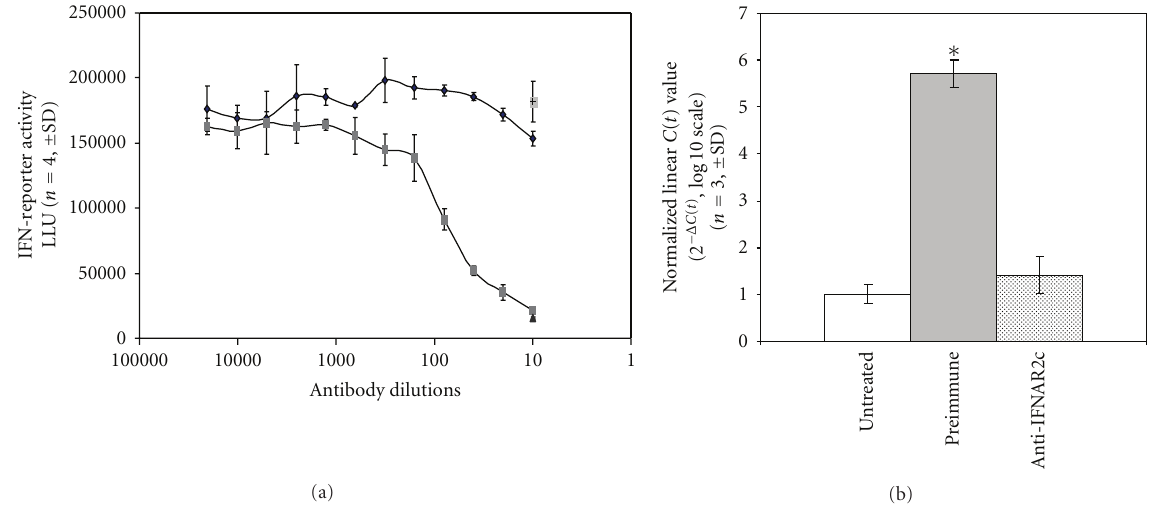
Figure 3: IFN- β induction of RGS1 is dependent on IFN-receptor activation . Neutralizing antisera recognizing the IFNAR2c IFN-receptor was incubated with PBMCs at various concentrations to determine the dilution necessary to achieve greater than 95% inhibition of an IFN-reporter assay (see Section 2). Figure 3(a): Cells (HT1080LUC) were incubated as previously described with preimmune (dark squares) or IFNAR2c antisera (gray squares). Antibody dilution is represented on the x -axis. The extent of IFN-reporter activation is shown on the y -axis represented as luciferase light units (LLU). IFN-reporter activity for IFN- β -stimulated HT1080LUC cells in the absence of antisera is also shown for comparison (single gray square). Data are presented as mean ( n = 4) ± SD. Figure 3(b): TaqMan analysis of IFN- β induced expression of RGS1 in the absence (untreated and preimmune) or presence (anti-IFNAR2c) of an IFN-receptor neutralizing antisera. RGS1 induction is expressed as linearized C ( t ) values normalized to GAPDH ( n = 3, mean ± SD). ∗ P < . 05.